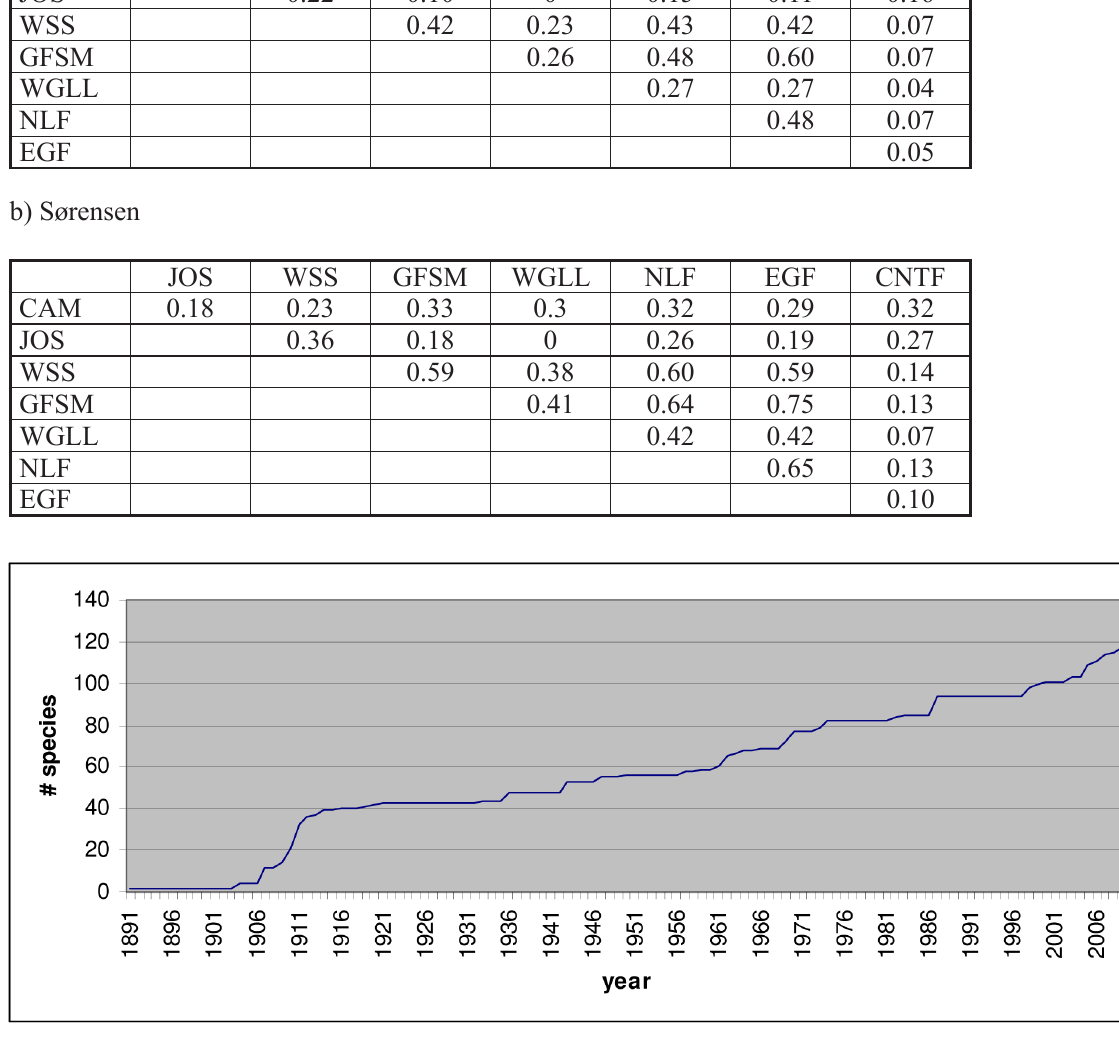
Fig. 3. Species accumulation curve for tephritid species recorded from study area.